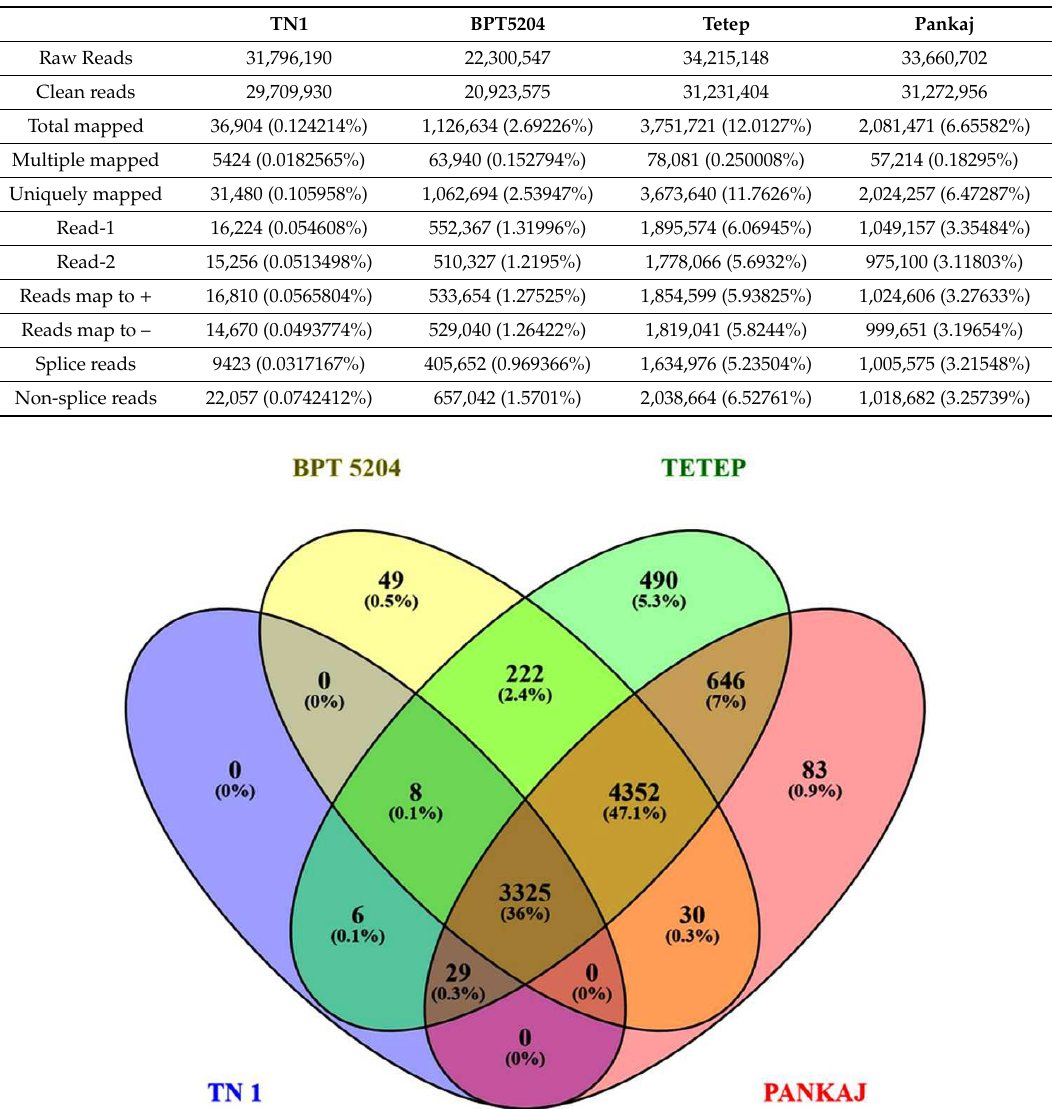
Table 1. Summary of R. solani transcriptome data obtained through RNA sequencing of fungal infected tissues of four rice cultivars. The sequences were filtered to acquire fungal encoded transcripts.